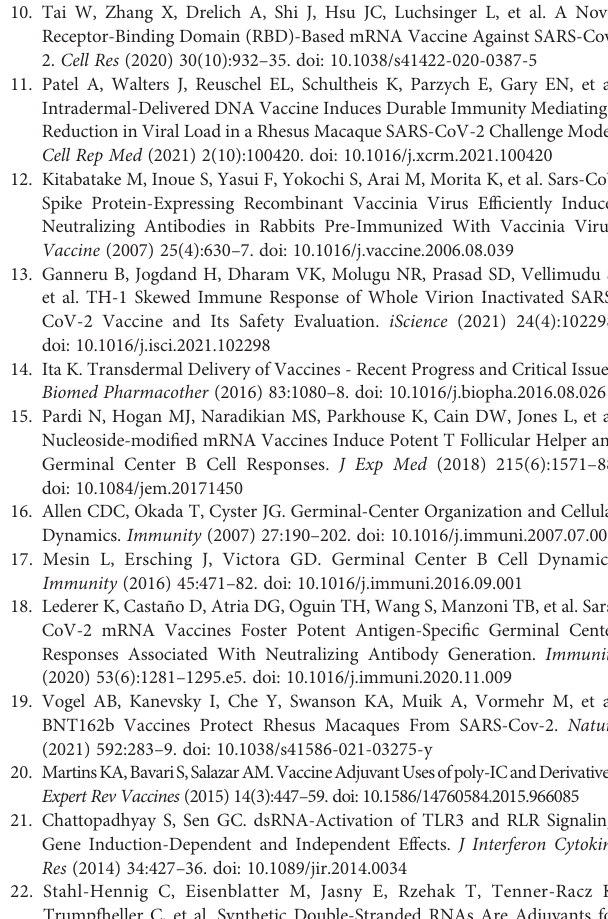
three immunizations by intradermal immunization with S Ptn plus Poly(I:C) or Poly(I: C) + Alum. Controls were performed with PBS. (A) Percentage of CD4 + T cells. (B) Number of CD4 + T cells. (C) Percentage of IFN- g + CD4 + T cells. (D) Number of IFN- g + CD4 + T cells. (E) Percentage of CD8 + T cells. (F) Number of CD8 + T cells. (G) Percentage of IFN- g + CD8 + T cells. (H) Number of IFN- g + CD8 + T cells. (SEM; n=5-15). Supplementary Figure 5 | Gating strategy for the fl ow cytometric detection of macrophages, eosinophils, T cells, and neutrophils in BALF. BALF cells were fi rst gated on a forward scatter/side scatter (FSC-A/SSC-A) and then on single cells using FSC-A/FSC-H. A sequential gating strategy was used to identify cellular populations expressing speci fi c markers: alveolar macrophages (AMs) (SiglecF + CD11c + ), eosinophils (SiglecF + CD11c - ), T cells (CD11b - TCR b + ), and neutrophils (CD11b + Ly6C - Ly6G + ). Supplementary Figure 6 | Spike protein + Poly(I:C) + Alum and Spike protein + Poly(I:C) induced high titers of neutralizing antibodies against Delta variant. Titers of neutralizing antibodies were determined in vitro by neutralization assay after three immunizations and PRNT50 and PRNT90 for mice plasma collected 7 days after third immunization. Figure representative of 2 experiments and shown as mean ± S.D. and analyzed by one-way ANOVA with Tukey ’ s post hoc test. *p<0.05 (SD; n=5-10). Supplementary Figure 7 | Protocol of Immunization. The animals received three immunizations, with the same dosage, with an interval of fourteen days between each dose. Blood samples was collected after two and three immunizations. Then, mice were challenge with inactivated SARS-CoV-2 and 24h later the mice were